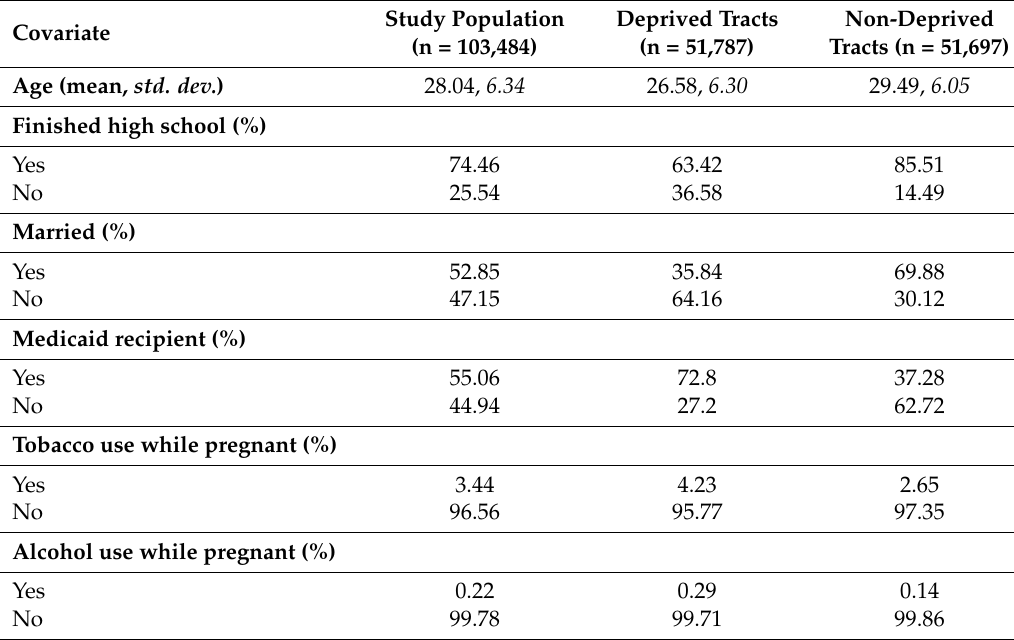
Table 2. Maternal